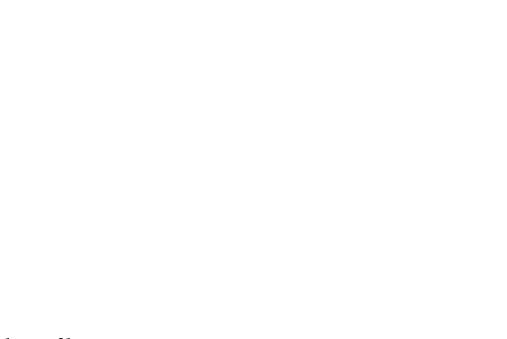
Table 1. Fault mode and fault value of Sallen key bandpass filter